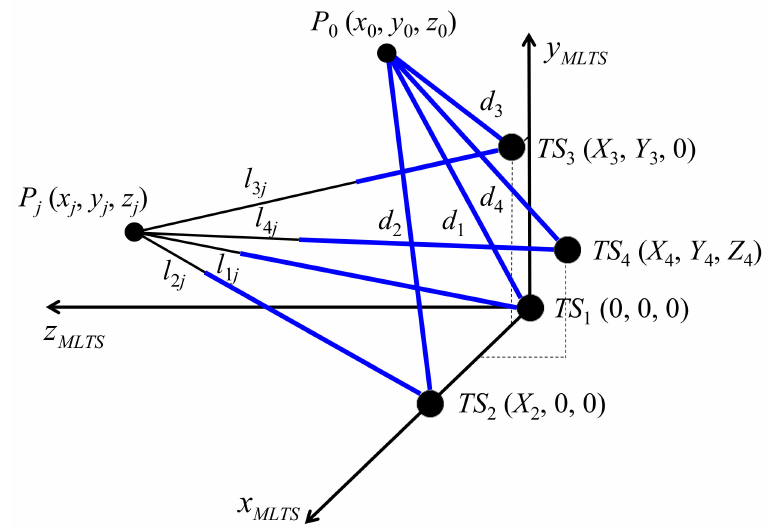
Figure 1. Schematic of the conventional self-calibration method for a multilateration tracking system using incremental distance